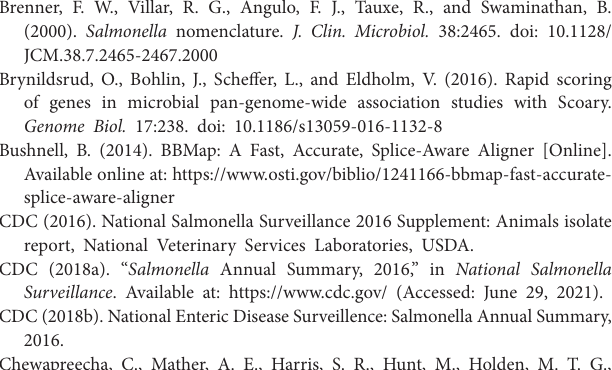
with a Lewis correction for ascertainment bias and 1,000 bootstrap repetitions; only bootstraps >70 are shown. The tree is rooted at midpoint. Supplementary Figure S2 | Comparison of core genes for strains characterized by RNA-seq following growth to late exponential phase in LB broth. (A) Overnight cultures of strains ( S. Cerro FSL R8-2349, FSL S. Javiana FSL S5-0395 and S. Typhimurium ATCC 14028S) grown in LB broth, were sub- cultured 1:1000 into fresh LB broth; enumeration of colonies was performed each hour following sub-culturing. Growth assays were performed as three independent experiments; the variance in CFU/mL is captured by the error bars, which represent standard deviations of the mean. Samples were collected for RNA-seq at late exponential phase, approximately 4 h after sub-culturing, as denoted with an arrow. (B) Venn diagram displaying the number of core genes among the three strains characterized by RNA-seq in our study. Gene presence/ absence was determined using Roary (Page et al., 2015). A total of 3,565 genes are core to all three strains. Supplementary Figure S3 | Rarefaction curves of gene presence/absence data for isolates included for pan genome determination for each serovar. Rarefaction curves of the core and pan genomes of S . Cerro ( n = 16), S . Javiana ( n = 16), S . Typhimurium ( n = 16), and all isolates ( n = 48). A full list of isolates included in this analysis can be found in Supplementary File S1 . Supplementary Figure S4 | Cluster analysis using a Euclidean distance matrix reveals that the transcriptomes of S. Cerro FSL R8-2349 and S. Javiana FSL S5-0395 are more similar to each other than to S. Typhimurium ATCC 14028S. A heat map of transcript abundances of all genes core to S. Cerro FSL R8-2349, S. Javiana FSL S5-0395, and S. Typhimurium ATCC 14028S ( n = 3,565), as determined with Roary (Page et al., 2015), across all three biological replicates (denoted as “Rep.”). Clustering was performed using the Ward’s minimum variance method (Ward, 1963) based on Euclidean distance matrices. Supplementary Table S1 | Primers used in our